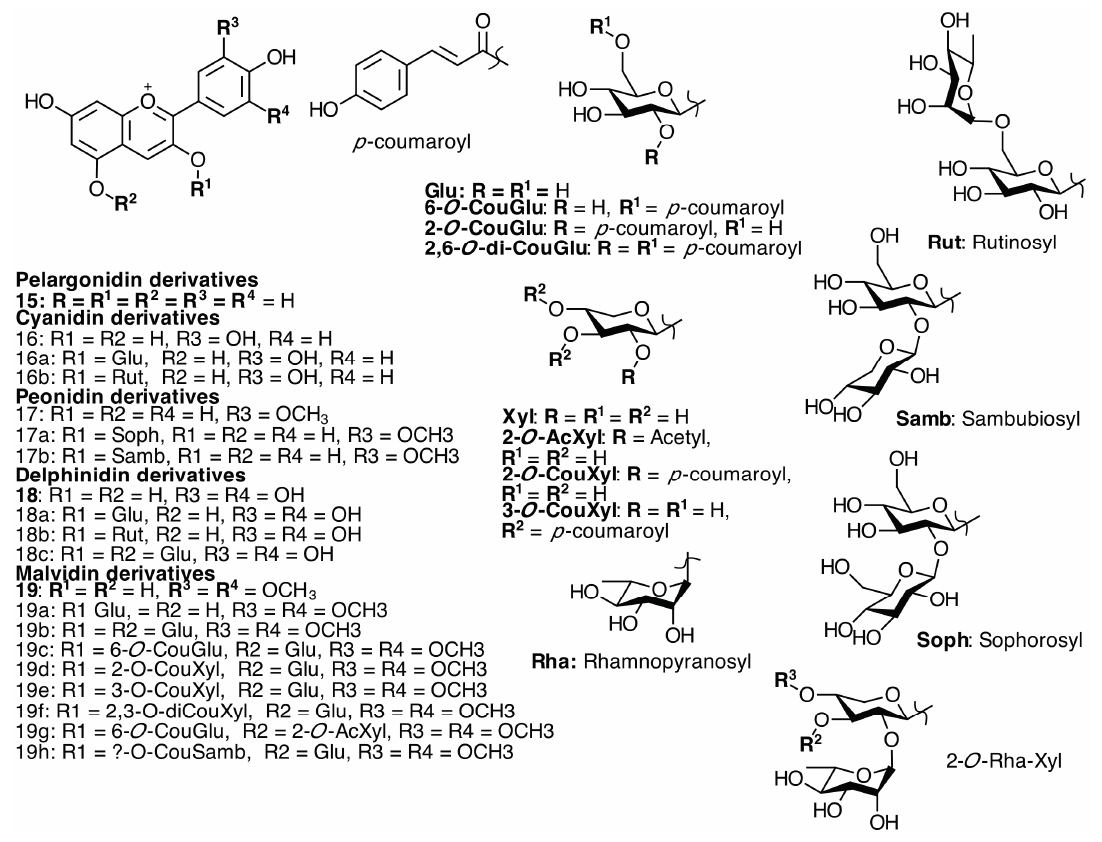
Figure 3. Flavonoids and derivatives isolated from Melastomataceae species.